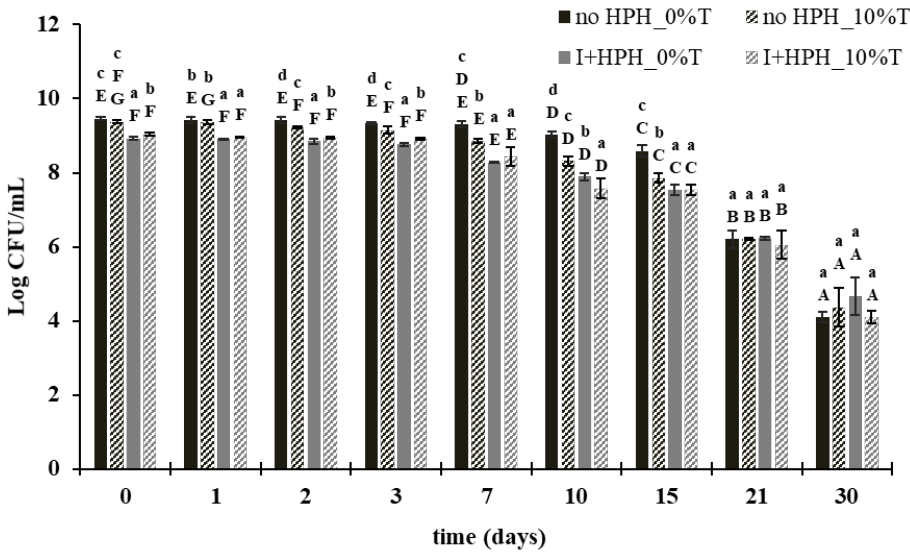
Figure 4. Microbial counts in clementine juice fermented with L. salivarius spp. salivarius CECT 4063 in cold storage for 30 days. Error bars represent the standard deviation of 4 replications. a–d In the same time and A–G in the same series indicate statistically significant difference with a 95% confidence level ( p < 0.05).